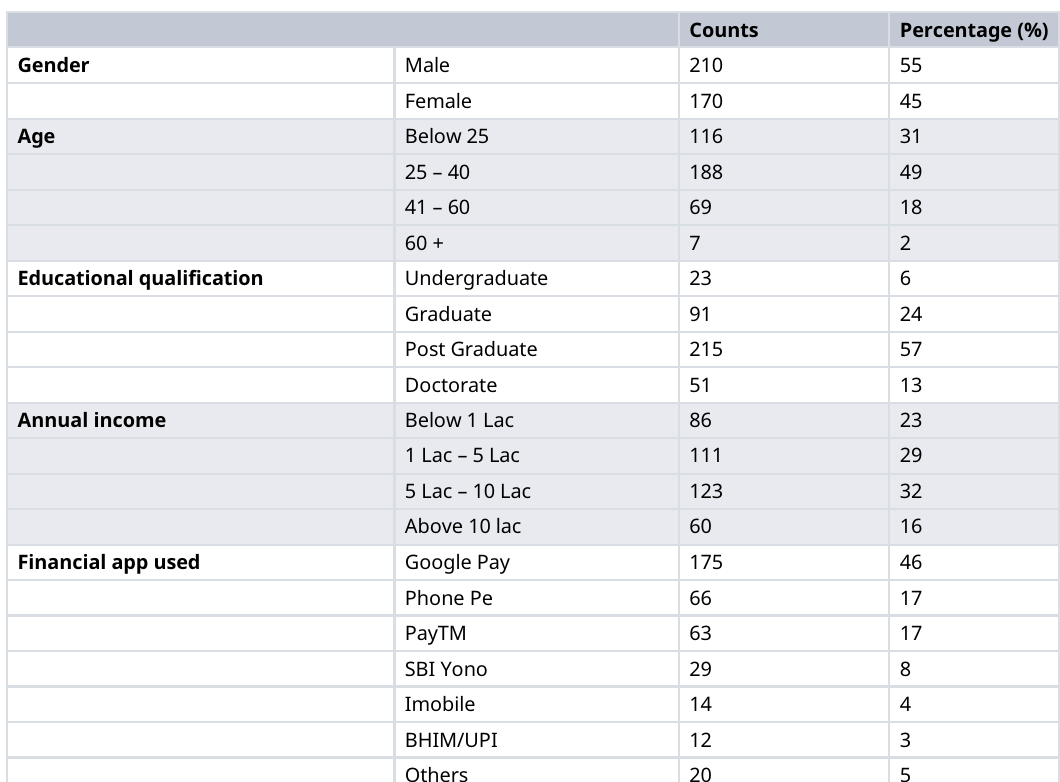
Table 1. Respondents ’ demographic and FinTech app usage